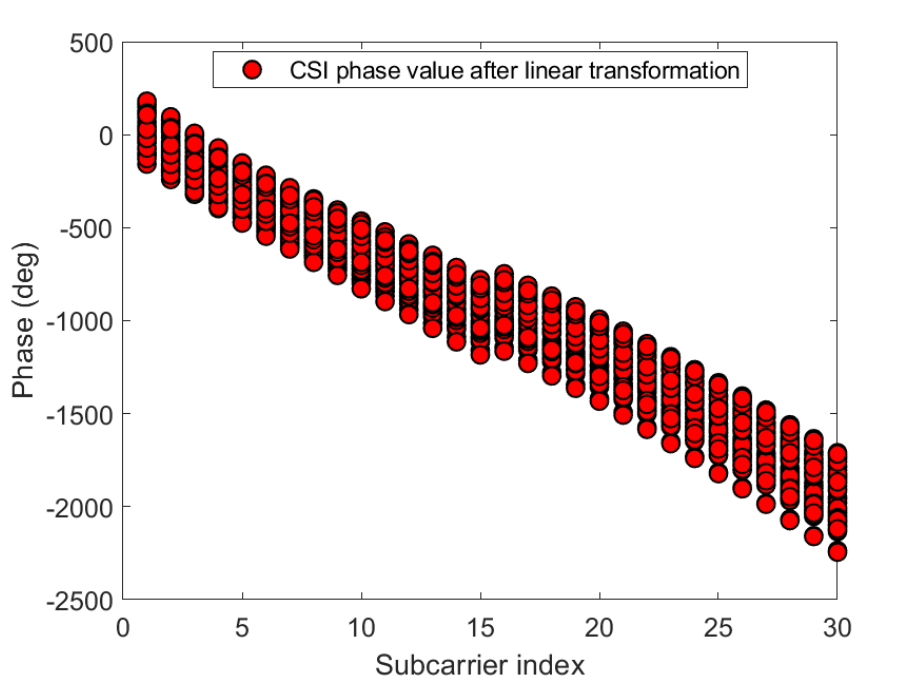
Figure 15. The phases after linear transformation of the 30 CSI sub-carriers on antenna a at reference point (0,1) of AP1 in the lobby of IT2